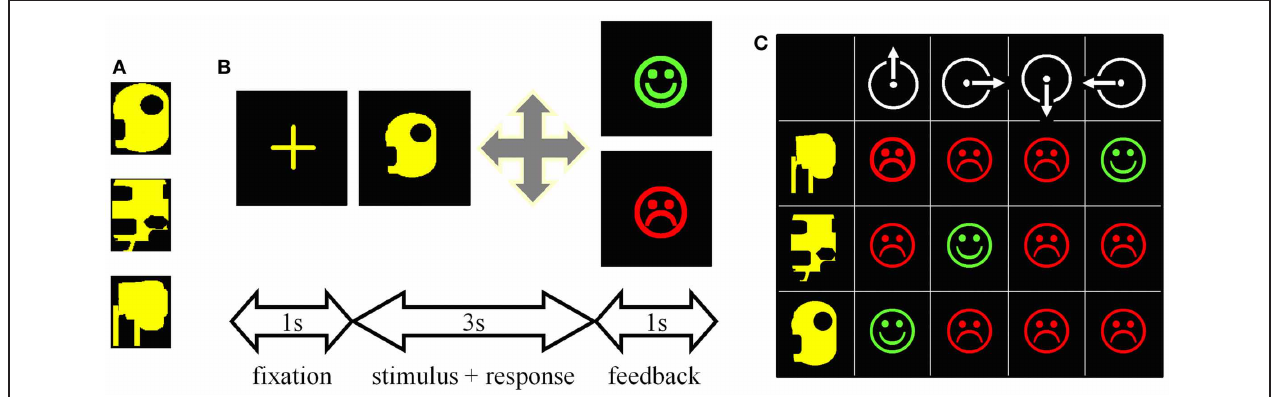
FIGURE 1 | Experimental task. (A) One of the trios of complex geometric patterns used as stimuli. (B) Trial time-course. First, a central cross appeared at the center of the screen for 1s. Then, one stimulus was presented for 3s during which the subject had to guess which among the four possible joystick displacements was associated with this stimulus. A correct response was followed by a green happy face, an incorrect one by a red sad face. Both feedbacks were presented for 1s. (C) Matrix summarizing the 12 possible associations to be tested when mapping 3 stimuli (rows) onto 4 joystick displacements